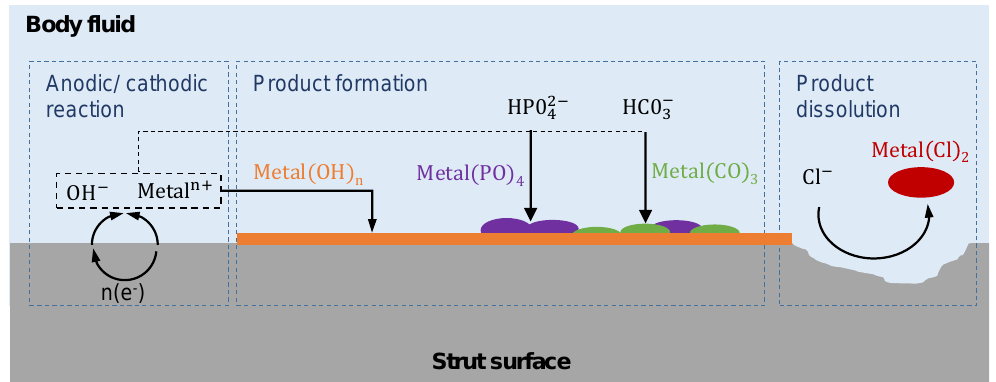
Figure 1. Schematic process sketch of the degradation process of absorbable metals according to Han et al. and Li